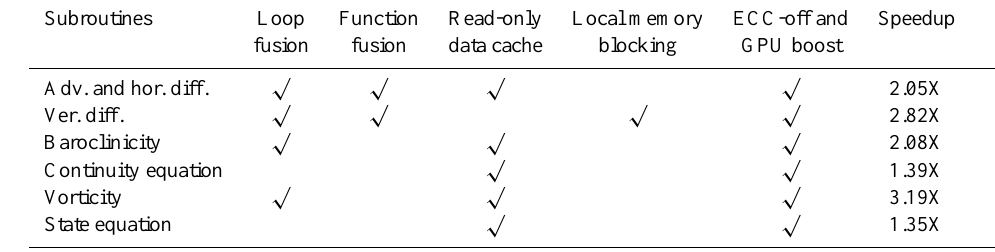
Table 2. Different subroutines adopt different optimizations in the POM.gpu. Subroutines Loop Function Read-only Local memory ECC-off and Speedup fusion fusion data cache blocking GPU boost √ √ √ √ Adv. and hor. diff. Ver. diff.